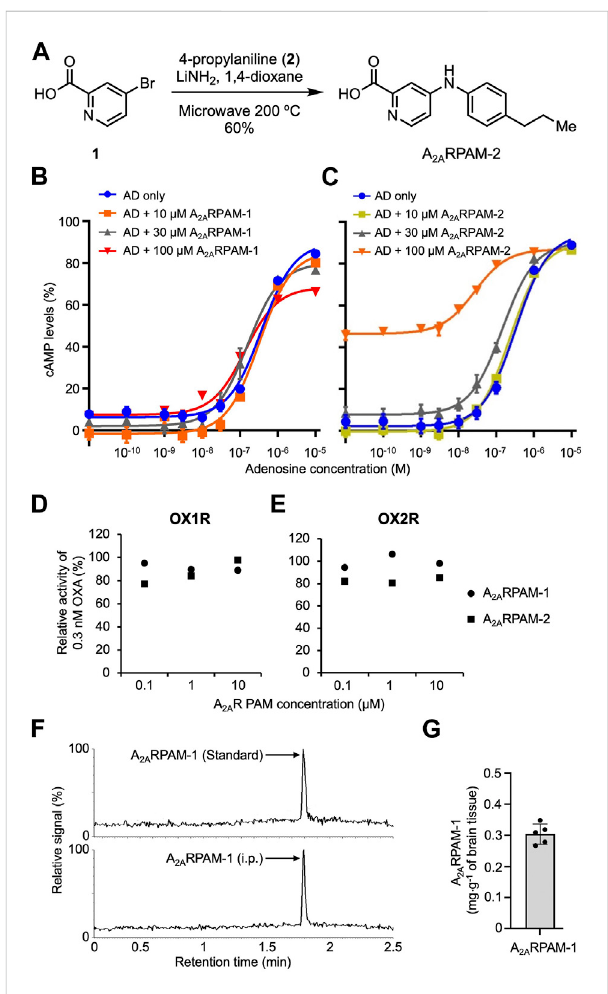
FIGURE 1 The monocarboxylic acids A 2A RPAM-1 and A 2A RPAM-2 are positive adenosine A 2A receptor allosteric modulators. (A) Chemical synthesis of A 2A RPAM-2. A 2A RPAM-2 was produced by combining 4- bromo-2-pyridinecarboxylic acid (1) and 4-propylaniline (2). (B,C) Dose-dependent changes of cAMP levels in mA 2A R-expressing Chinese hamster ovary cells after treatment with various adenosine (AD) and A 2A RPAM-1 (B) or A 2A RPAM-2 (C) concentrations. Experiments were performed in triplicate wells for each condition and data are presented as mean ± SEM. (D,E) Antagonistic activity of A 2A RPAM-1 and A 2A RPAM-2 against human orexin A (OXA) at orexin-1 receptors (D, OX 1 R) and orexin-2 receptors (E, OX 2 R) in a cell-based calcium assay. Experiments were performed in duplicate wells for each condition and data are presented as mean ± SEM. (F,G) UPLC- MS/MS analysis of brain samples from mice injected intraperitoneally with 75 mg kg -1 A 2A RPAM-1. Single-ion (m/z 392) signals (F) and